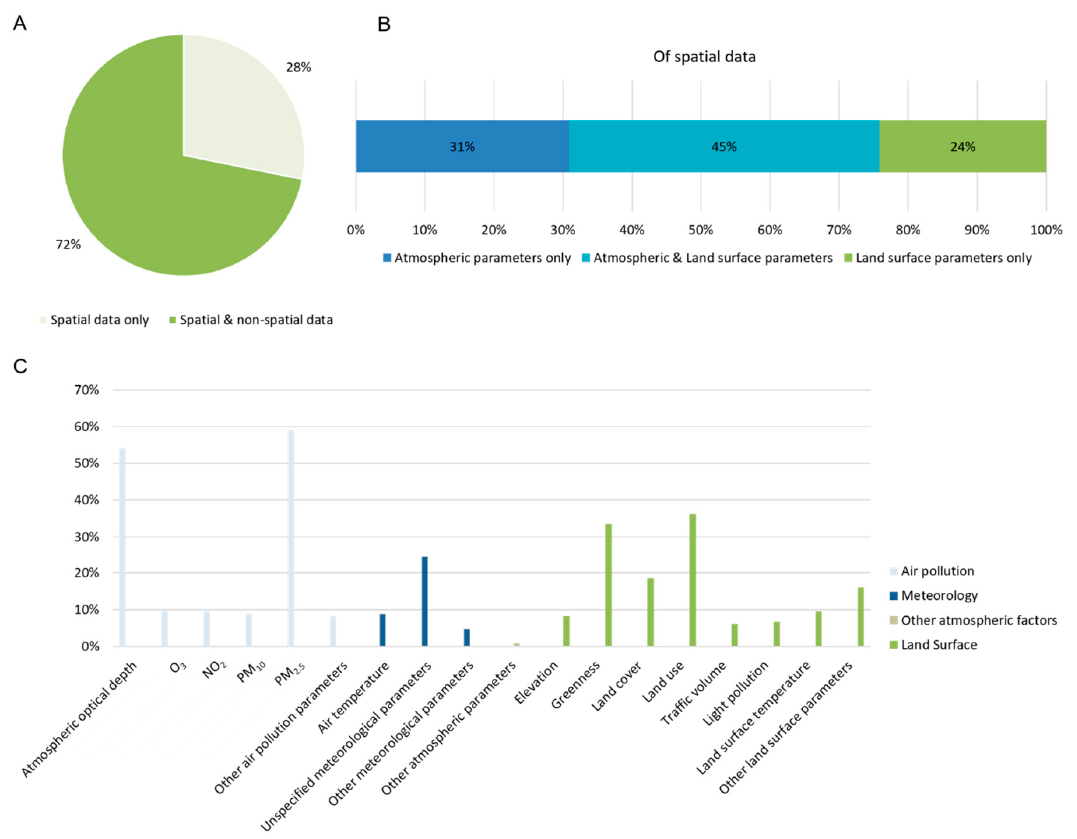
Figure 8. Overview of spatial data used in the studies investigated. ( A ) represents the shares of studies that used spatial data and non-spatial data; ( B ) offers a closer look at the focus of included spatial information; ( C ) presents how frequently approaches relied on the individual Earth Observation (EO) parameters.